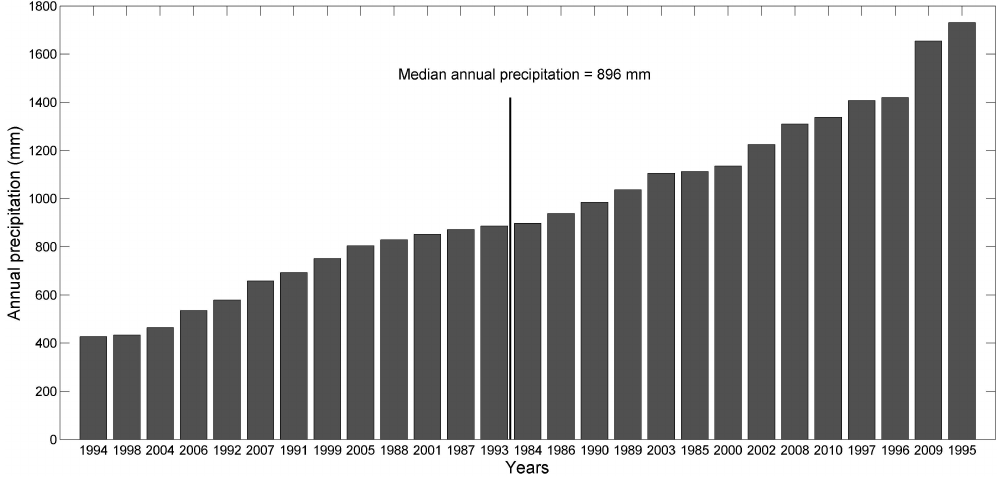
Fig. 3. Precipitation amounts during dry and wet years, sorted in ascending